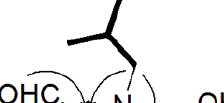
Figure 2. Key 1 H- 1 H COSY (bolded items) and HMBC (arrows) correlations of compound 1 .